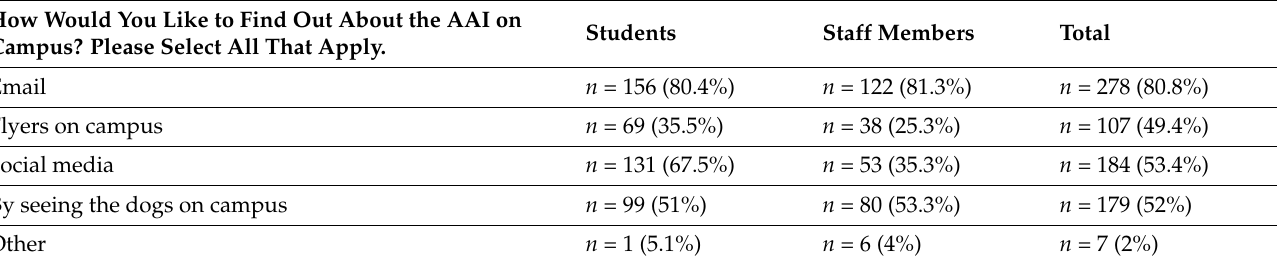
Table 4. Preferred way to find out about an AAI on